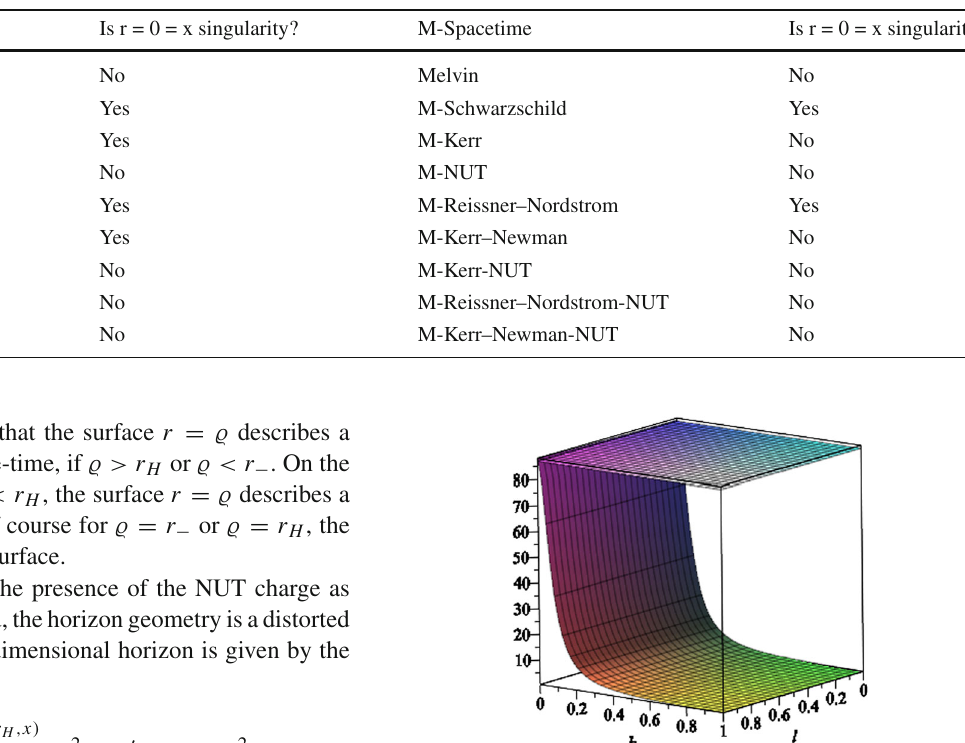
Table 1 Singularity at r = 0 = x